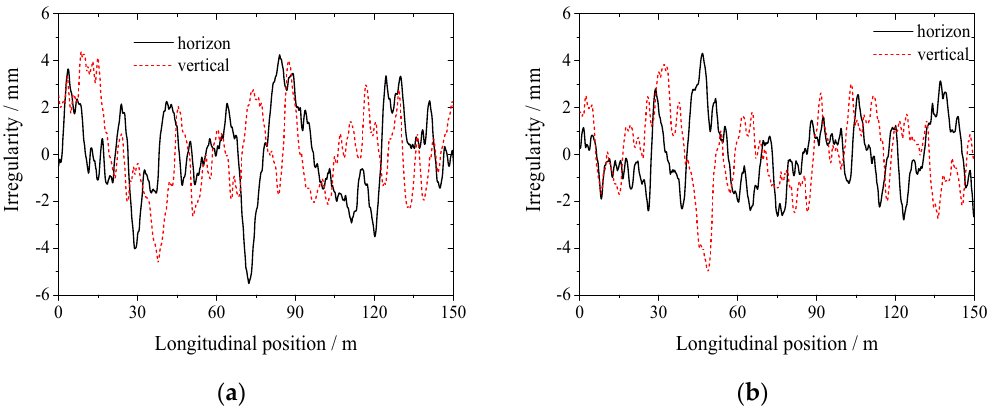
Figure 4. Random irregularity selected in the model. ( a ) Vertical and horizon irregularity of left rail; ( b ) Vertical and horizon irregularity of right rail.